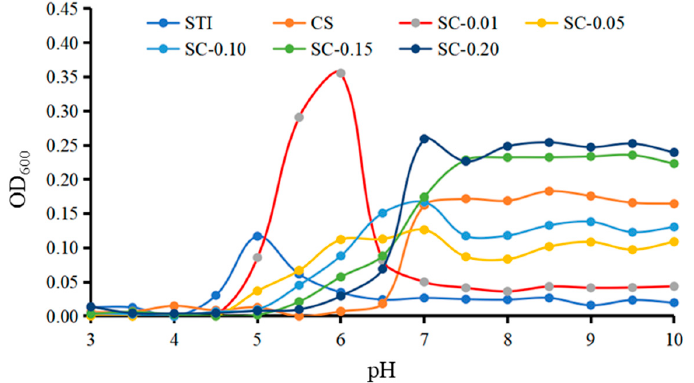
Figure (cid:561) 2. (cid:561) The (cid:561) turbidity (cid:561) changes (cid:561) of (cid:561) STI, (cid:561) CS, (cid:561) and (cid:561) mixed (cid:561) systems (cid:561) (SC–0.01, (cid:561) SC–0.05, (cid:561) SC–0.10, (cid:561) SC–0.15, (cid:561) Figure 2. The turbidity changes of STI, CS, and mixed systems (SC–0.01, SC–0.05, SC–0.10, SC–0.15, SC–0.20) over different pHs.